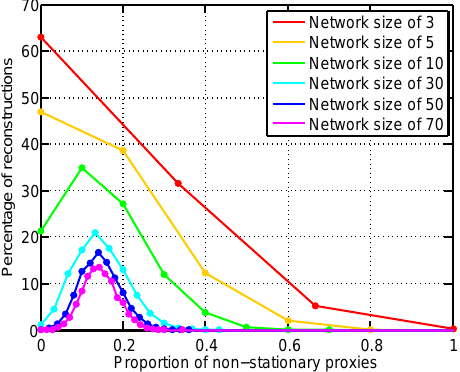
Figure 6. This plot shows the percentage of TS-based reconstruc- tions ( y axis) with certain proportions of non-stationary proxies ( x axis) for the RND glb_ts experiment. Each of the ten 31-year cal- ibration windows has been included in these calculations, so that the proportions of non-stationarities for 10000 reconstructions are shown (50% being 5000 reconstructions). Different lines are for different proxy network sizes (see inset legend), and this determines what values of proportion can be taken; hence, larger groups have a wider range of possible non-stationarity proportions than smaller groups. The coloured circles of any proportions with 0% of recon- structions have not been